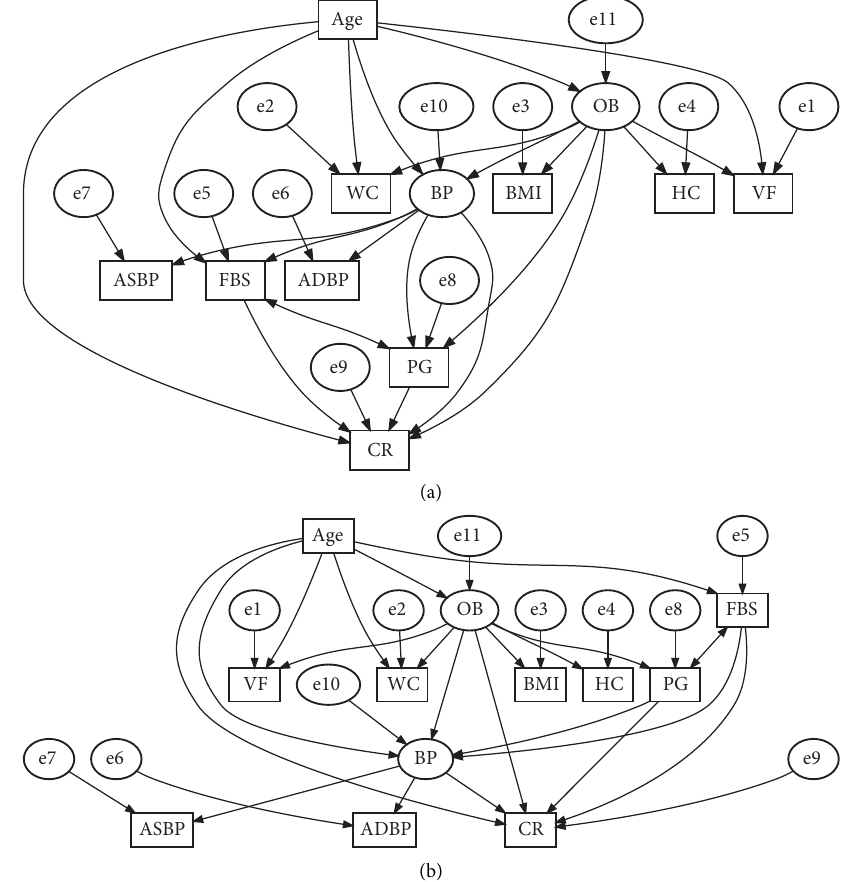
Figure 1: Conceptual models. (a) Conceptual model 1, (b) Conceptual model 2.